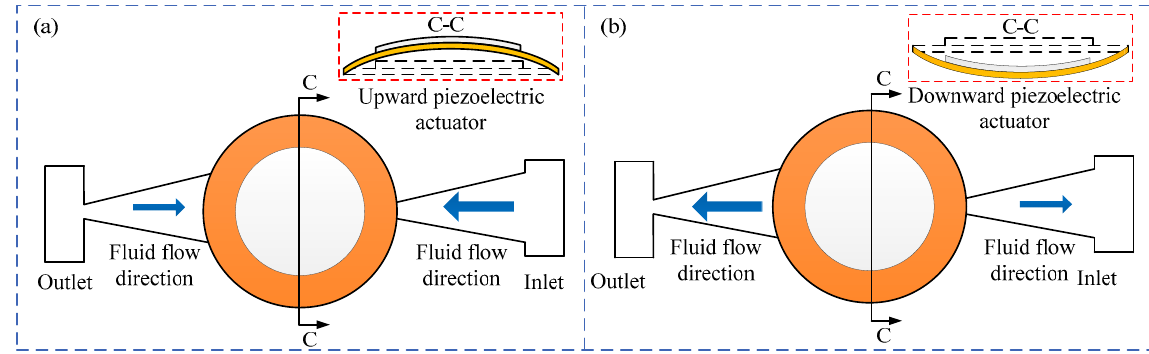
Figure 2. The working processes of valveless piezoelectric pumps with diffuser/nozzle tubes. ( a ) Suction process. ( b ) Discharge process. Table 1. Summary of properties for the valveless piezoelectric pump with external flow tubes.